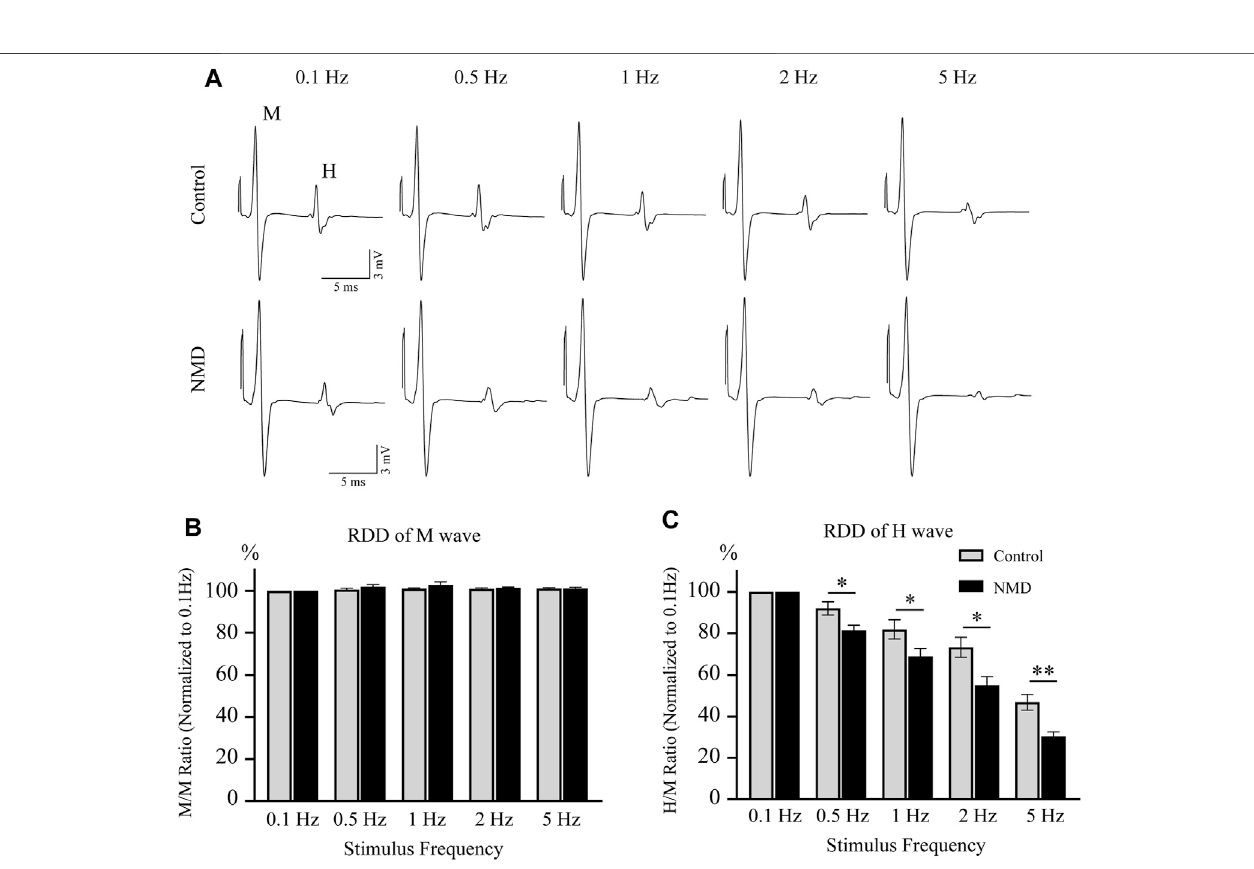
FIGURE 3| Long-term treatment with NMD alleviatesspasticity-like symptoms. (A) Representative tracesof M and H waveforms upon stimulation at 0.1, 0.5, 1, 2 or 5 Hz. (B) The RDD of the M wave in each group is shown ( n (cid:1) 11 rats in each group). Two-way repeated-measures ANOVA, p > 0.05, F (1, 20) (cid:1) 1.513. (C) Graphs present the RDD of the H wave ( n (cid:1) 11 rats in each group). Two-way repeated-measures ANOVA, p < 0.01, F (1, 20) (cid:1) 12.04; post hoc Fisher ’ s test, * p < 0.05 at 0.5, 1, and 2 Hz, ** p < 0.01 at 5 Hz. p (cid:1) 0.0163 (0.5 Hz), 0.0412 (1 Hz), 0.0102 (2 Hz), and 0.0016 (5 Hz).